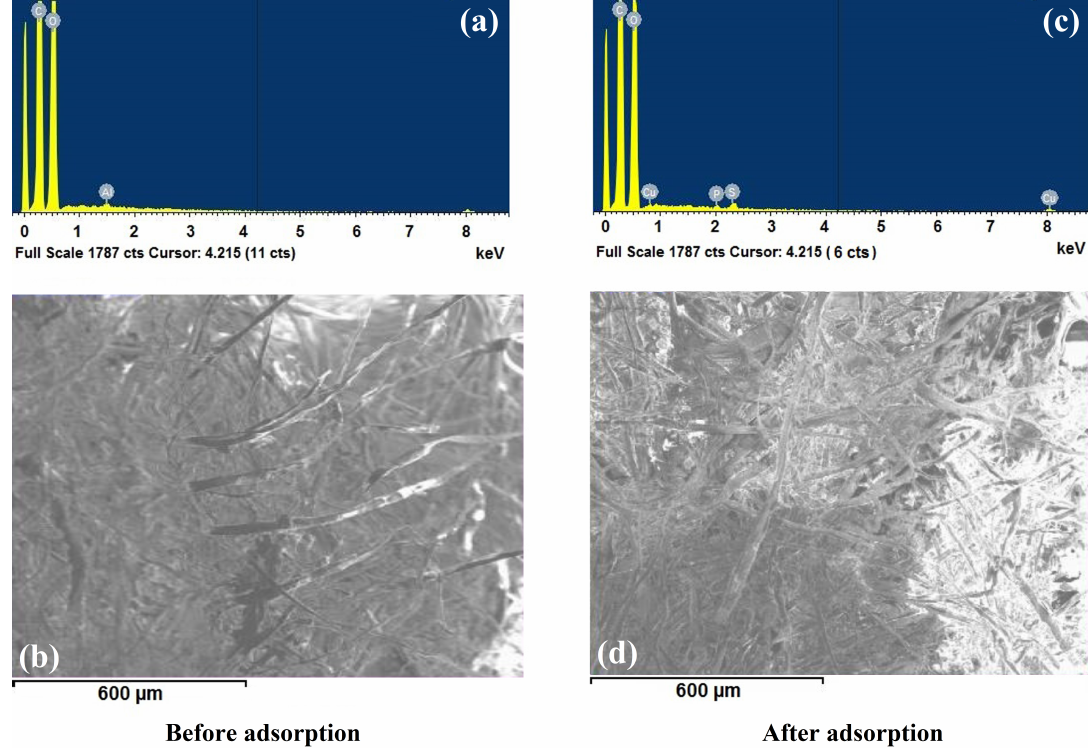
Figure 3. Elemental analysis ( a , c ) and SEM images ( b , d ) of PVC before and after the adsorption